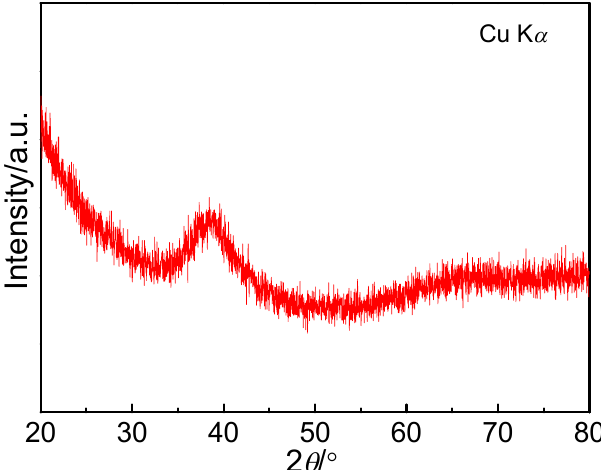
Figure 1. XRD pattern of the melt-spun Fe 68 Nb 6 B 23 Mo 3 ribbons.